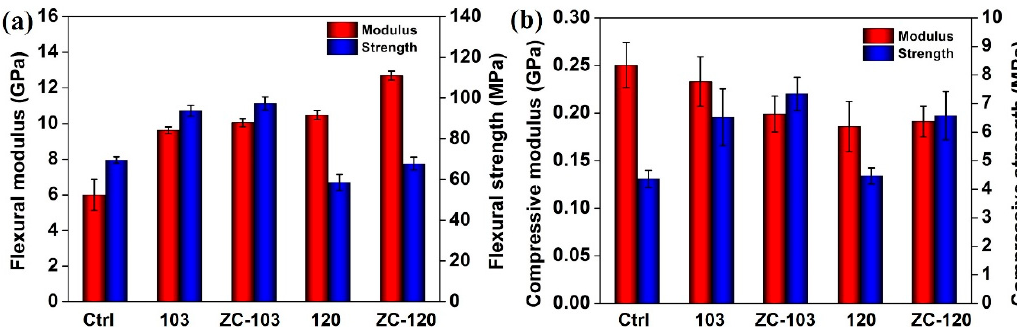
Figure 8. Flexural strength and modulus ( a ) and transverse compressive strength and modulus ( b ) of the wood samples after treatment with 10% DM + 10% MA in 103, ZC-103, 120, and ZC-120